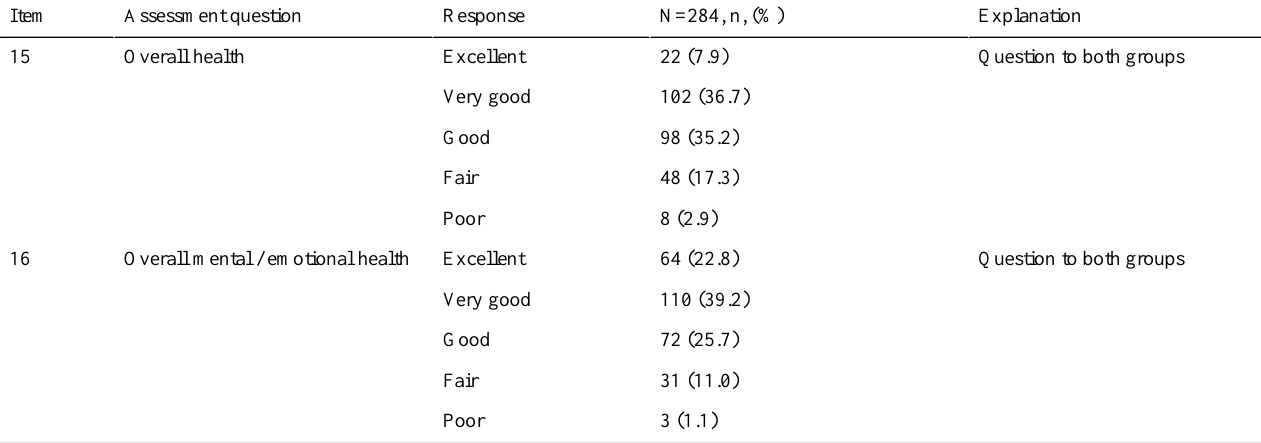
Table 2. Survey results, medical conditions.